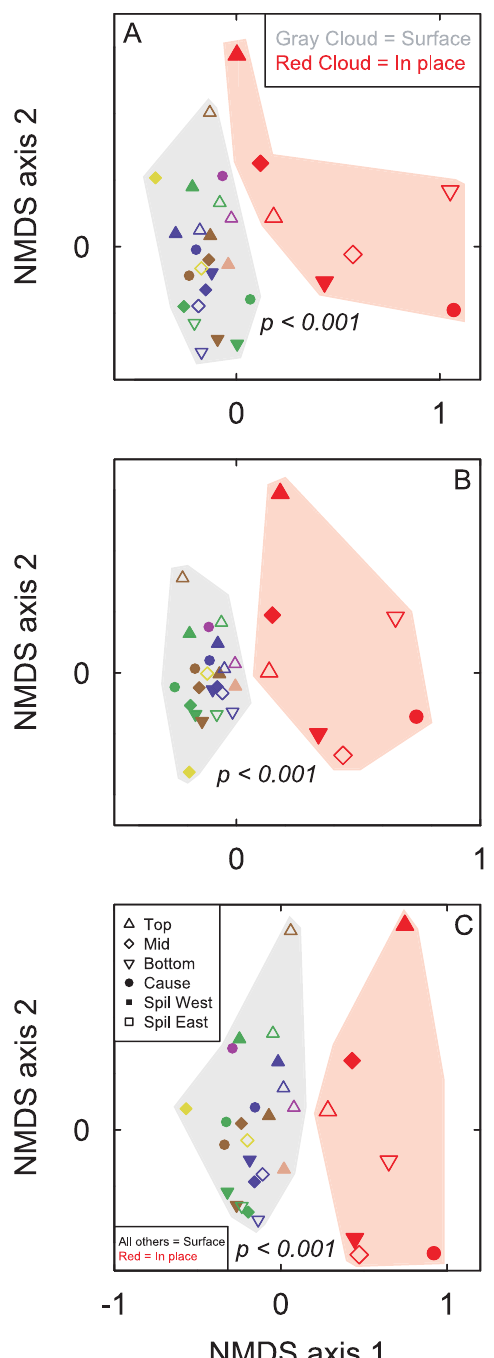
Fig 4. NMDS ordination of samples by collector. Non-metric multidimensional scaling (NMDS) ordination of all samples, with all surface samples identified by individual collector (as identified by the color of the smaller, non-red points), for (A) all taxa with abundance counts, (B) all taxa using presence/absence, and (C) mollusks and brachiopods with abundance counts. Spillway East outcrop samples are represented by open points, Spillway West outcrop samples are represented by closed triangles and diamonds, and Causeway Road outcrop samples are represented closed circles. Larger red points are in-place samples. Smaller points of all other colors are surface samples. Each of the six colors (other than red) represents a different surface collector. The gray and red shading are meant to further distinguish the in-place and surface collected sample points. P-values result from the PERMANOVA testing for differences between the two sampling